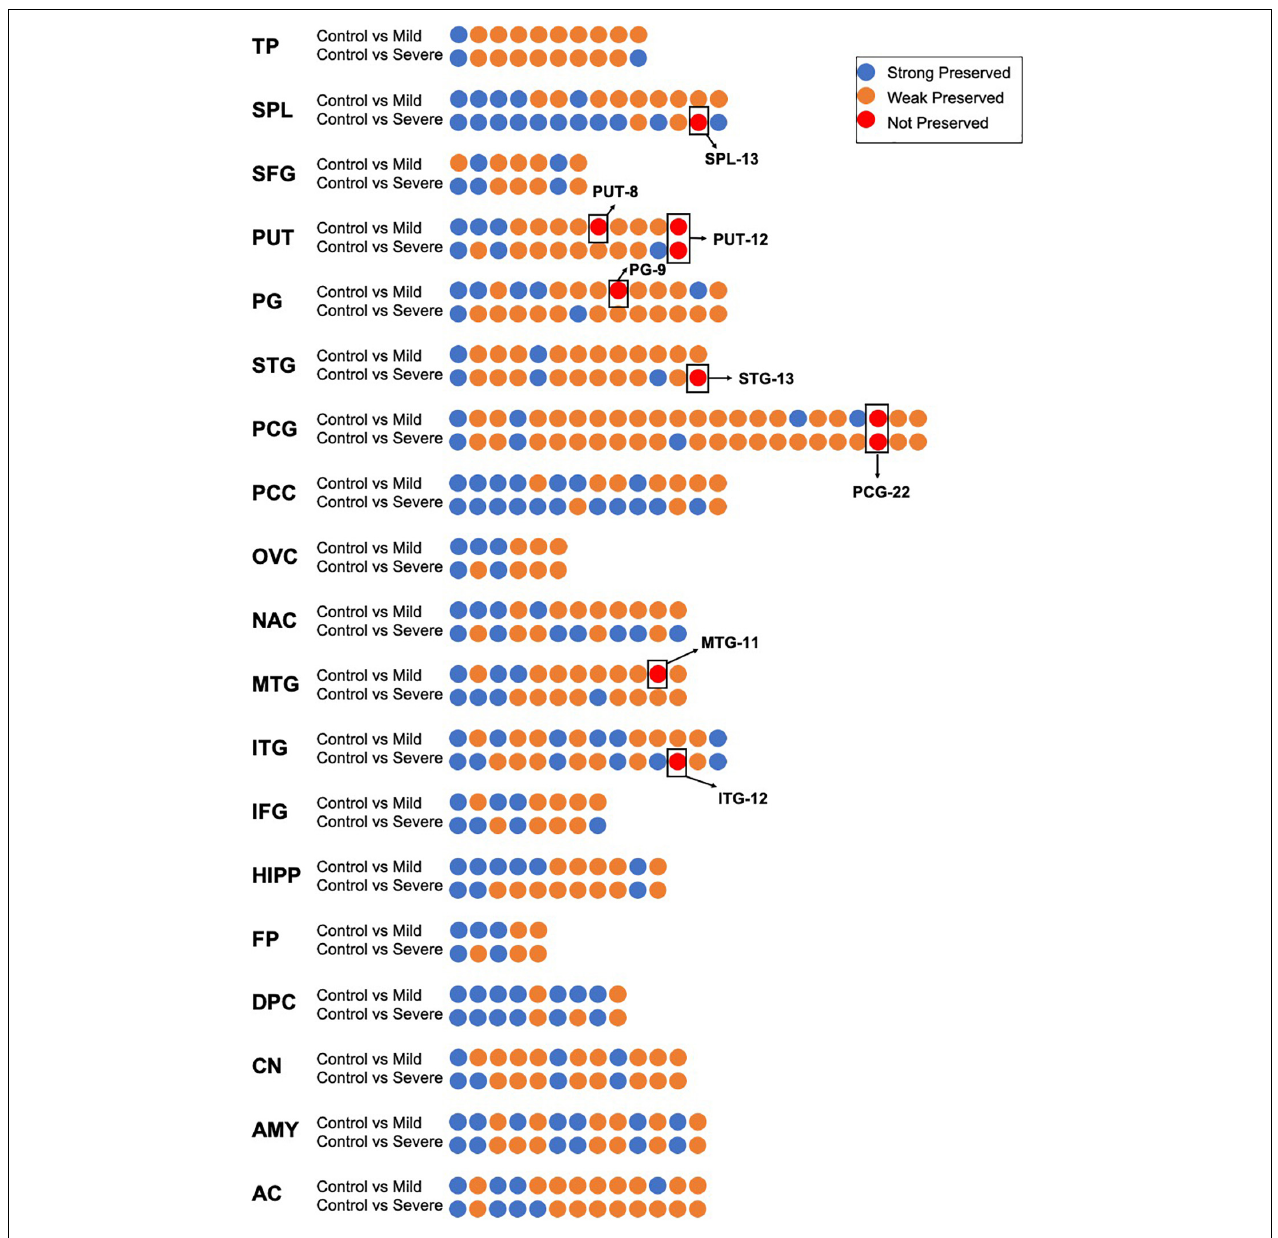
FIGURE 2 | The preservation evidence of control co-expression modules in different disease stages and different brain regions. For each brain region, co-expression networks in control group was compared with networks in mild and severe groups, co-expression modules are show as dots, which are sorted according to module size and colored according to their preservation evidence. Blue: strong preservation evidence; yellow: weak preservation evidence; red: none preservation